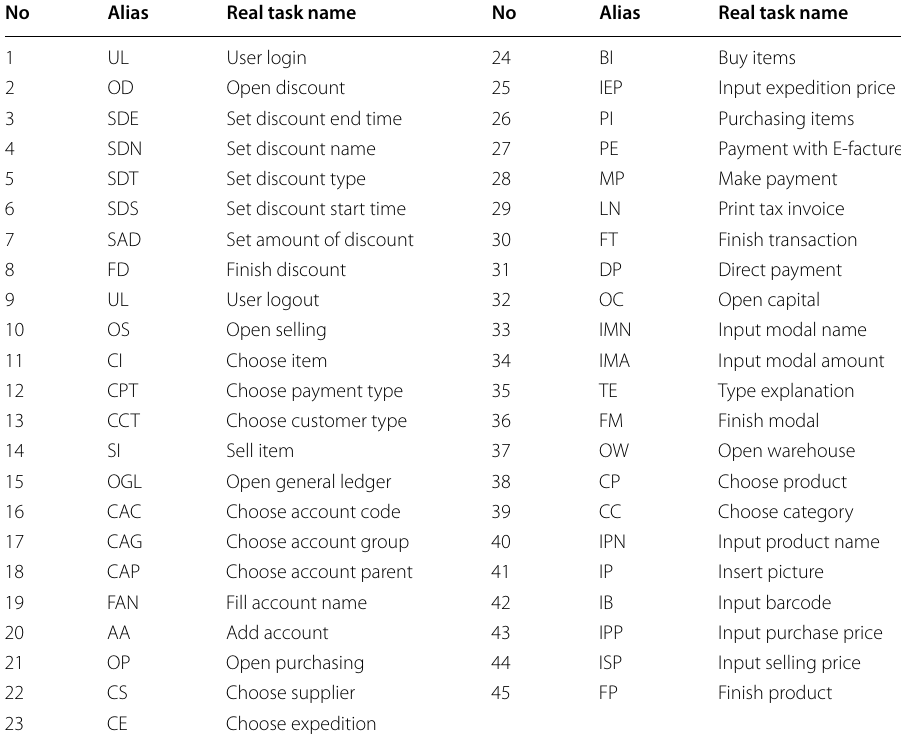
Table 8 List of activity names initialized in Fig. 4